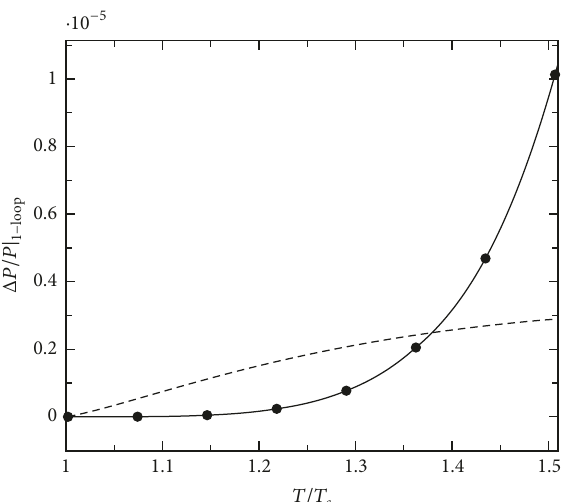
/𝑃| 𝜆 1− loop close to 𝑐 (dots). loop |/𝑃| 1− loop loop